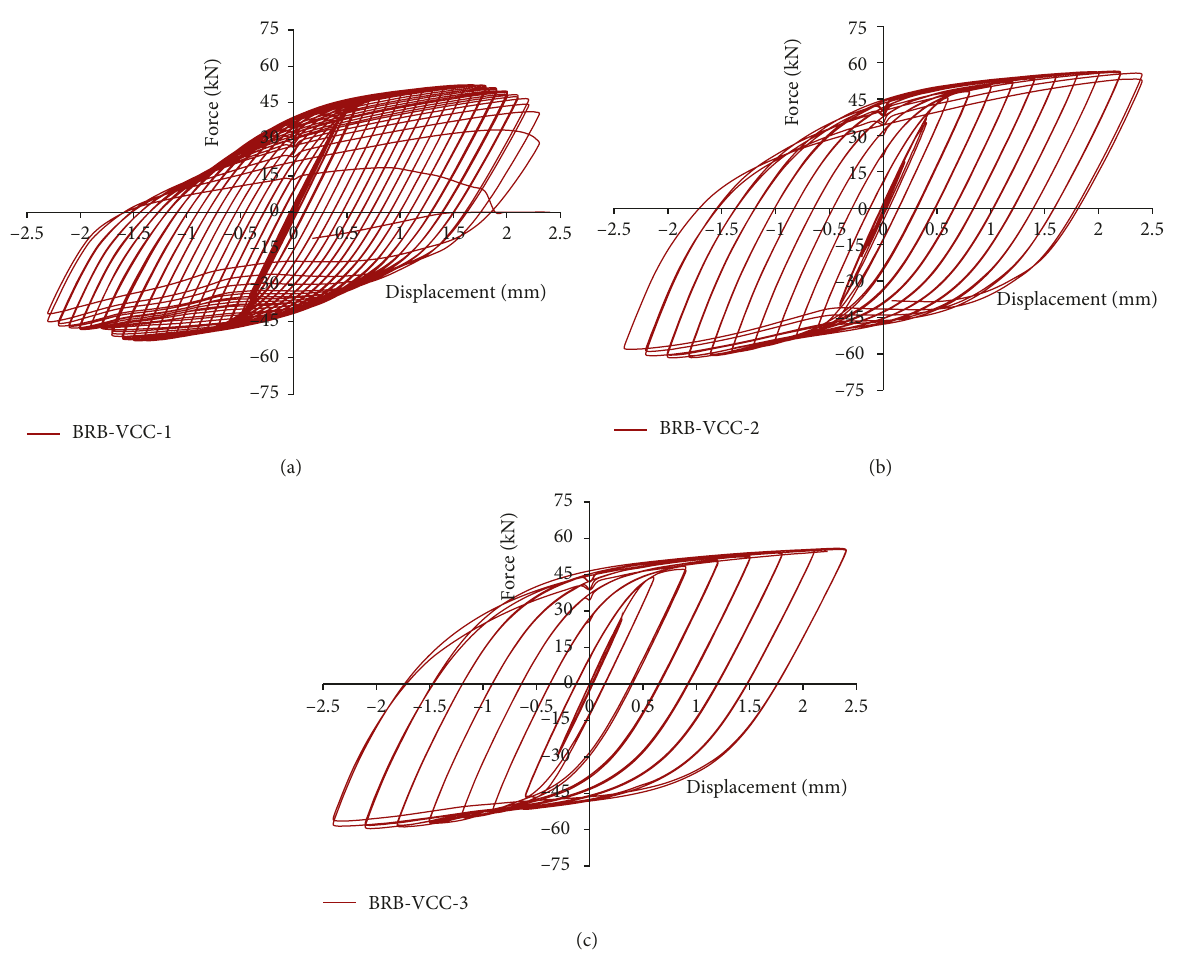
Figure 10: Hysteresis loops of S-I. (a) BRB-VCC-1. (b) BRB-VCC-2. (c)